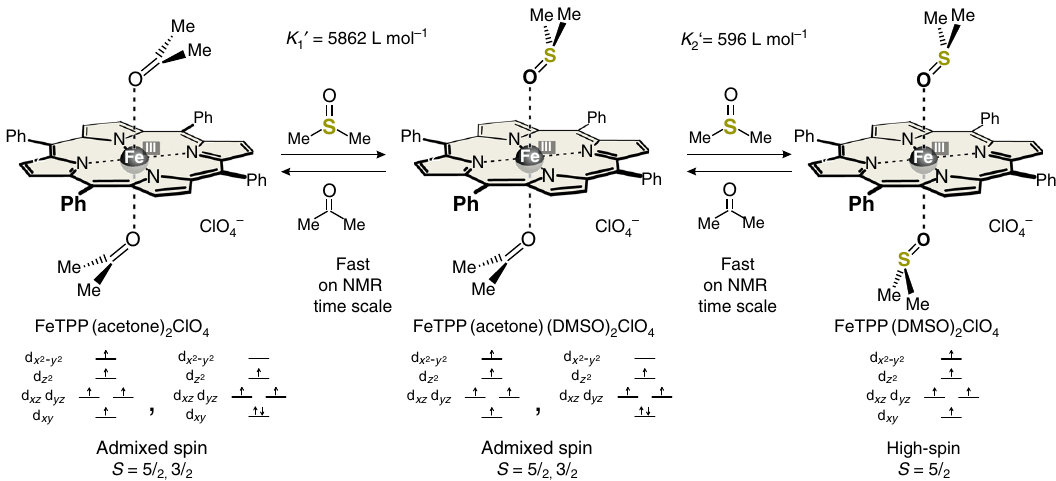
Fig. 1 Determination of formation constants. Formation constants of high-spin FeTPP(DMSO) 2 ClO 4 determined by following the absorption at 686 nm upon titration of the FeTPP(acetone)2ClO 4 complex in acetone with DMSO- d 6 at 25 °C. These values were con fi rmed by NMR titration